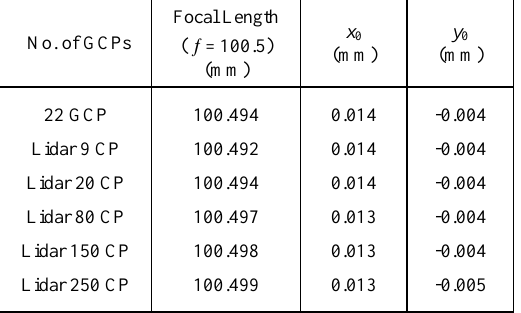
Table 2: Refined camera